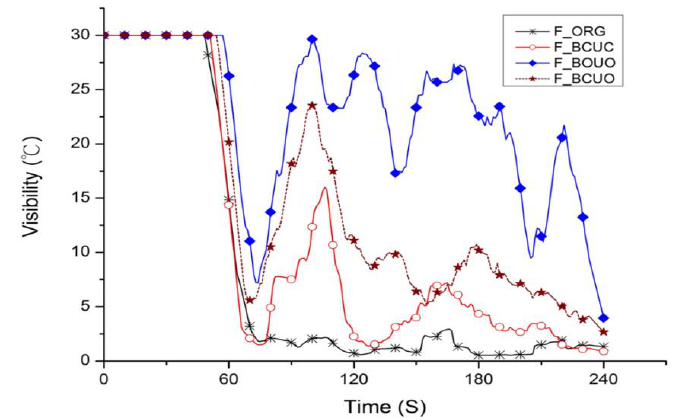
Figure 19. Visibility curves at Point R (at a height of 1.8 m).